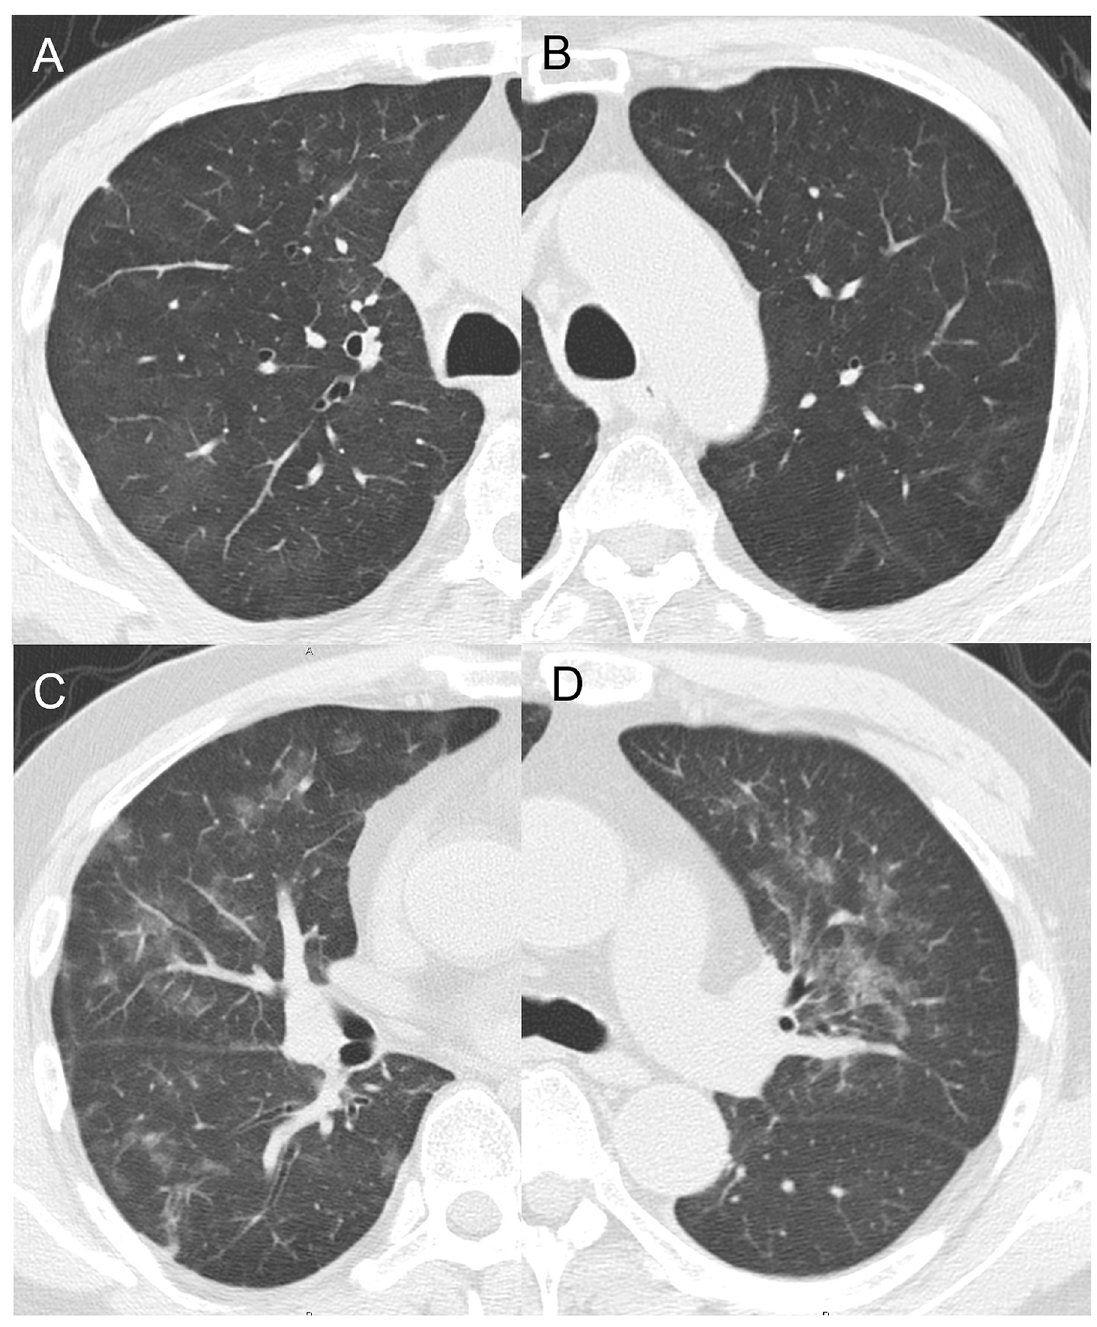
Fig 2. CT imaging of two patients with DI-IP. (A, B) A 67-year-old male patient with hypopharyngeal carcinoma after definitive CRT for primary disease with developing axillary lymph node metastasis. After PD with nivolumab, the patient underwent nine cycles of PC therapy. He was asymptomatic at the time of the CT scan, which was performed to assess the effectiveness of his treatment, and his KL-6 level was elevated to 550 U/ml (reference range: < 500U/ml). However, later developed symptoms of dyspnea of the patient and was diagnosed as grade 2 DI-IP. The patient improved with follow-up. (C, D) A 57-year-old male patient with maxillary carcinoma after curative CRT for the primary disease developed localized recurrence where radical excision was impossible. After PD with nivolumab, he underwent nine cycles of PC therapy. He developed respiratory symptoms, such as fever and cough, and a CT scan to investigate the source of inflammation showed non-distracting frosted glass shadows in both lung fields. The serum KL-6 level was elevated to 860 U/ ml. The patient was diagnosed as grade 3 DI-IP. He was treated with steroid pulse therapy and improved. CT, computerized tomography; DI-IP, drug-induced interstitial pneumonia; CRT, concurrent chemoradiotherapy; PD, progressive disease.